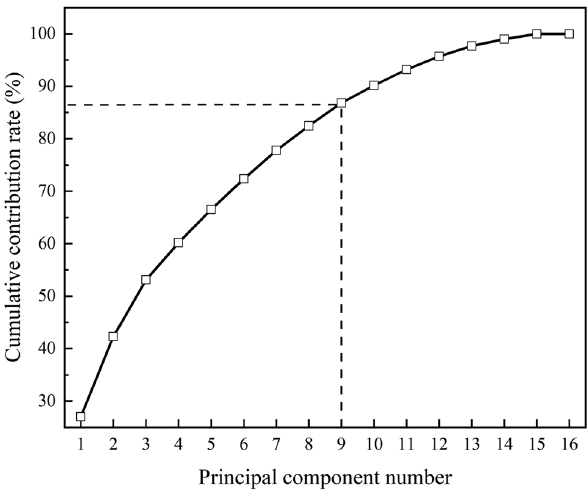
Figure 5: Cumulative contribution rate of principal